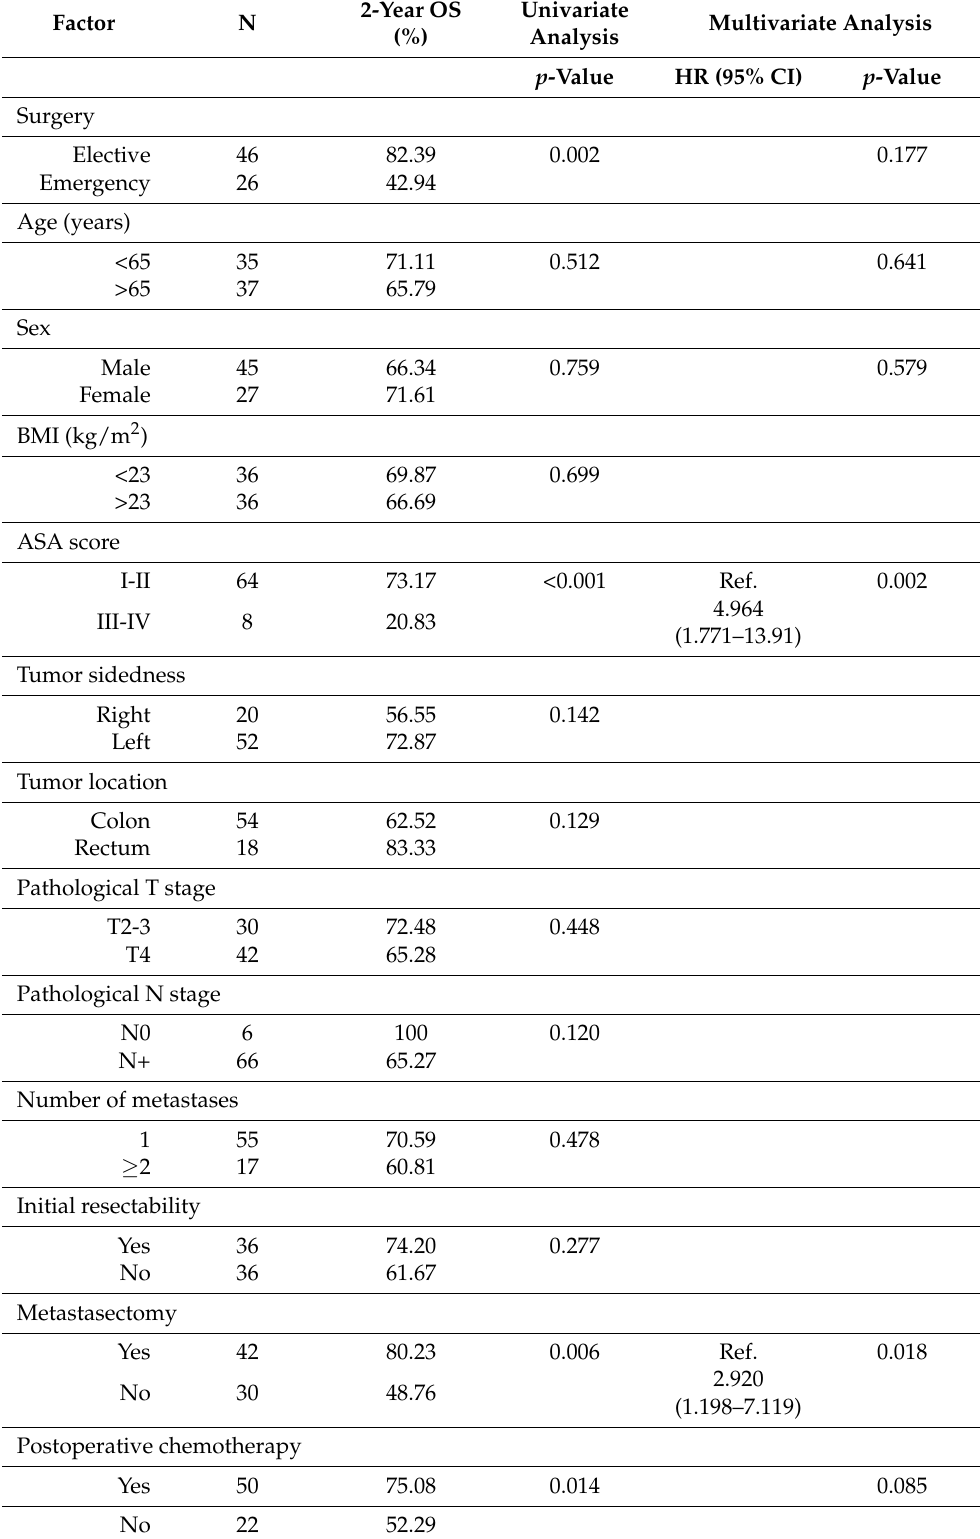
Table 4. Analysis of factors associated with 2-year overall